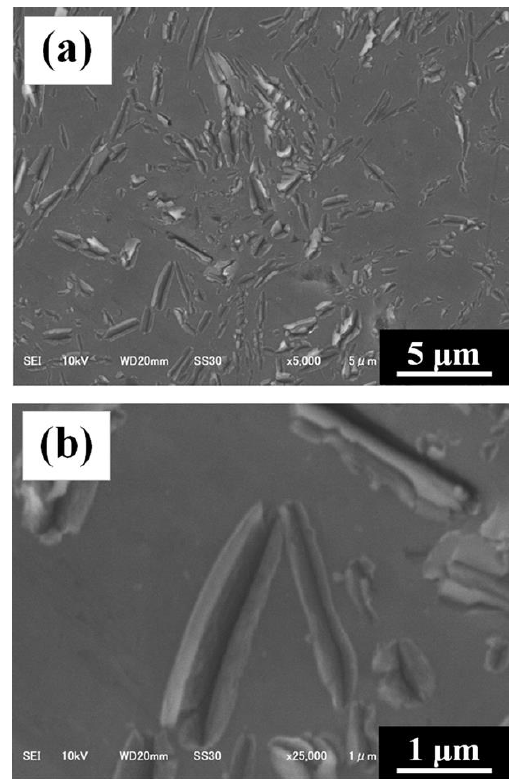
Figure 7. SEM images of vertical cross sections of the optimally processed material. ( b ) is enlarged image of ( a ).